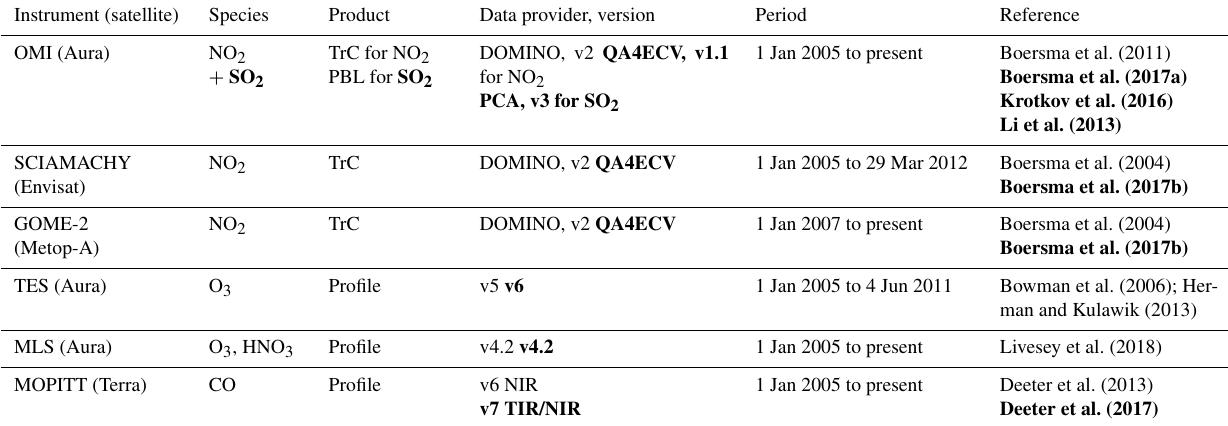
Table 4. Observations used for ozone assimilation in TCR-1, and changes for TCR-2 are shown in bold. Instrument (satellite) Species Product Data provider,